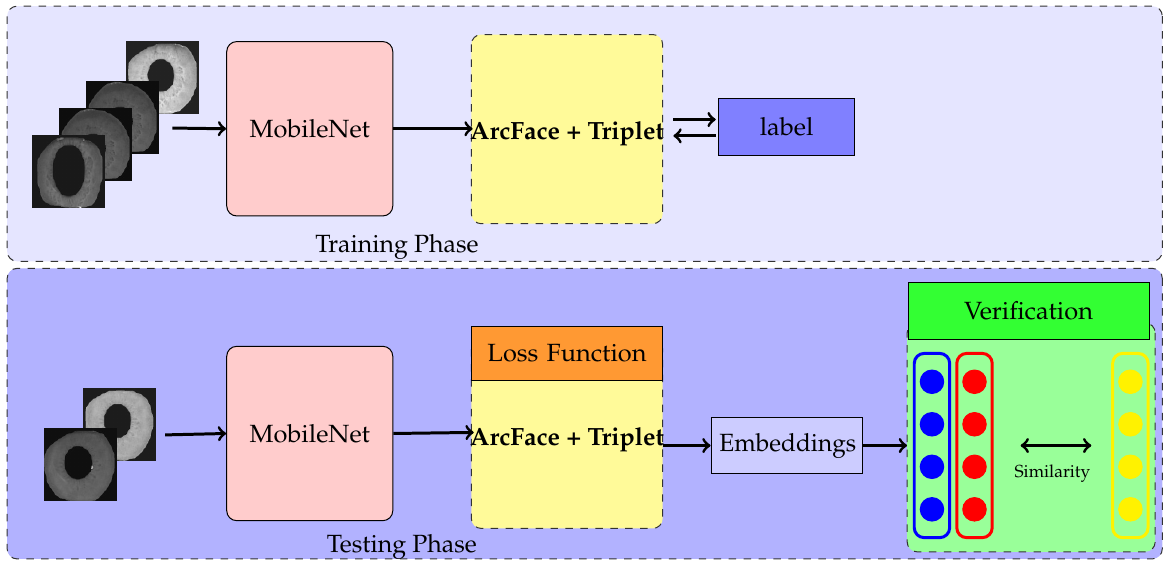
Figure 1. Overview of the proposed